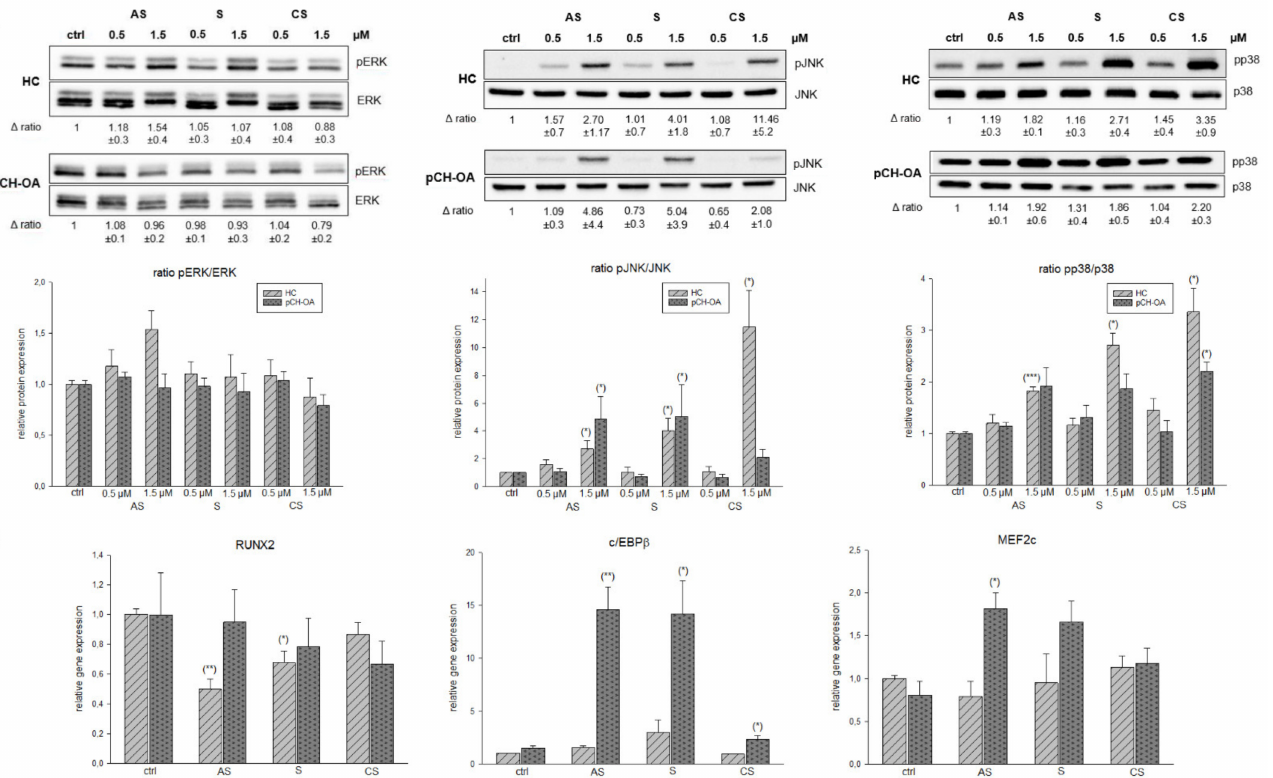
Figure 4. Shikonin derivatives induced an activation of MAPKs and their corresponding downstream targets. ( A ) The ERK/JNK/p38 protein phosphorylation was evaluated by immunoblotting under untreated control conditions (ctrl) and in the presence of 0.5 µ M and 1.5 µ M acetylshikonin (AS), shikonin (S), and cyclopropylshikonin (CS) for 1 h in HC and IL-1 β -stimulated pCH-OA cells. The unphosphorylated ERK/JNK/p38 were used as loading controls. ∆ ratio represents the fold change of phosphorylated and non phosphorylated kinases normalized to controls (mean ± SD, n = 3). ( B ) shows the densiometric evaluation of all experiments in HC (light grey striped) and pCH-OA (dark grey dotted) cells. ( C ) Relative gene expression of the downstream targets RUNX2, c/EBP β , and Mef2c after treatment with shikonin derivatives for 24 h (mean ± SD, n = 6, measured in triplicates). Statistical significances are defined as follows: * p < 0.05; ** p < 0.01; *** p <